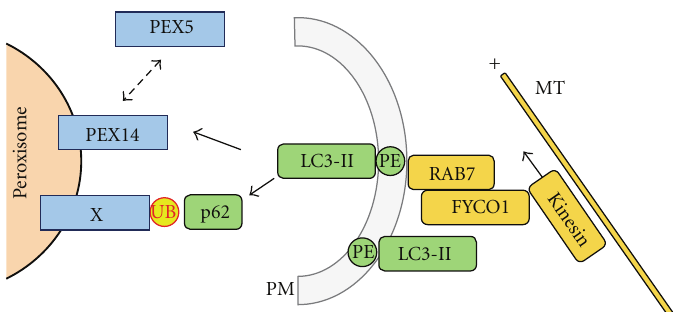
Figure 7: Hypothetical mechanistic model of pexophagy in mammalian cells. Processed and lipidated LC3 (LC3-II) is integrated into the expanding phagophore membrane (PM) and also may be involved in facilitating directed movement of the PM structure by interacting with microtubules (MT) via the RAB7 e ff ector FYCO1 and motor protein Kinesin. Targeting of peroxisomes may either be accomplished by p62-mediated detection of ubiquitin (UB) motifs on still unknown peroxisomal membrane (or membrane associated) proteins (X) or by direct binding of LC3 to PEX14, a process which is discussed to compete with the binding of PEX5 to PEX14 (dotted arrow). See text for